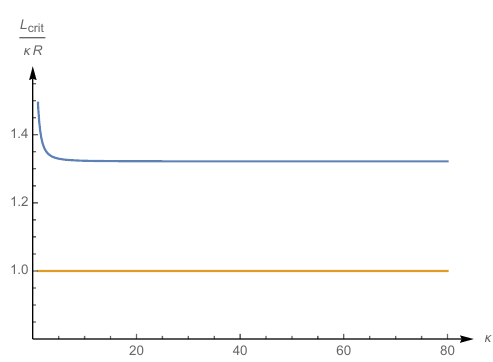
Figure 16. Plot of L cric : as function of (cid:20) . This quantity is decreasing with the (cid:13)ux, but always (cid:20)R greater than